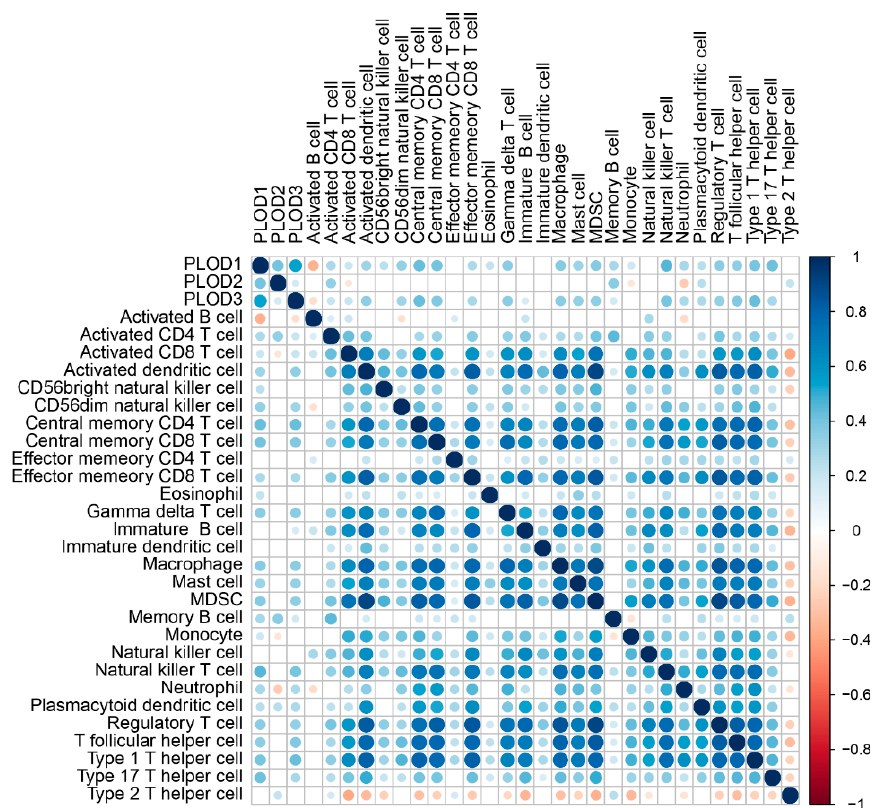
Figure 6. The immune landscape of PLOD family members and 28 immune cell types in STS.